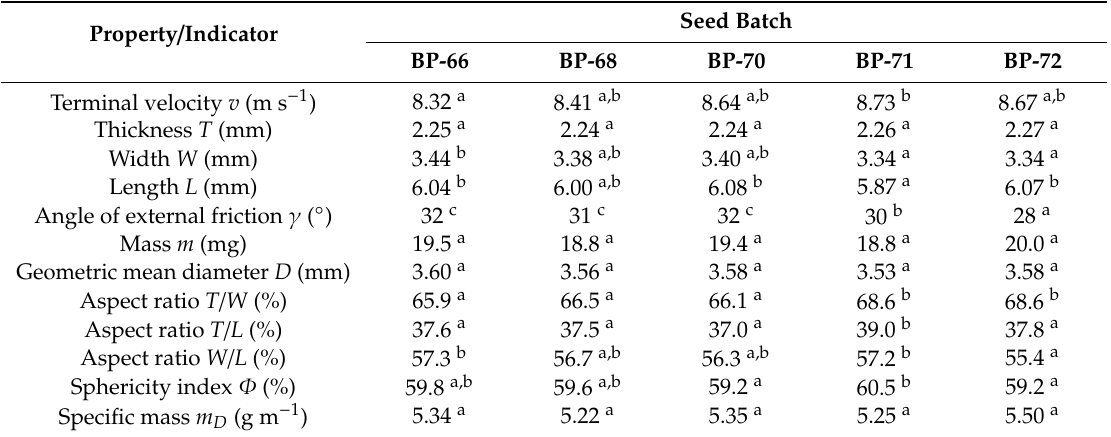
Table 1. Mean values of the physical properties of black pine seeds and the significance of di ff erences. Property /